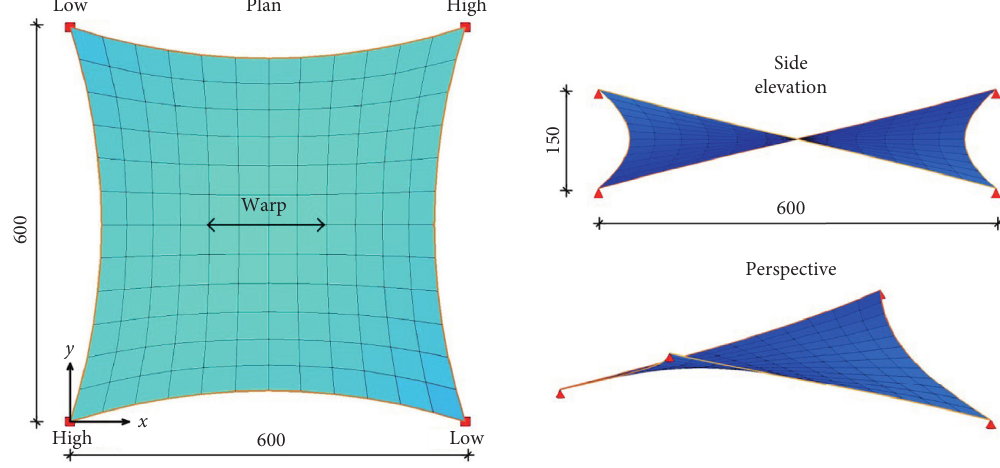
Figure 1: Geometry of the initial model. Table 1: Variable parameters used in the